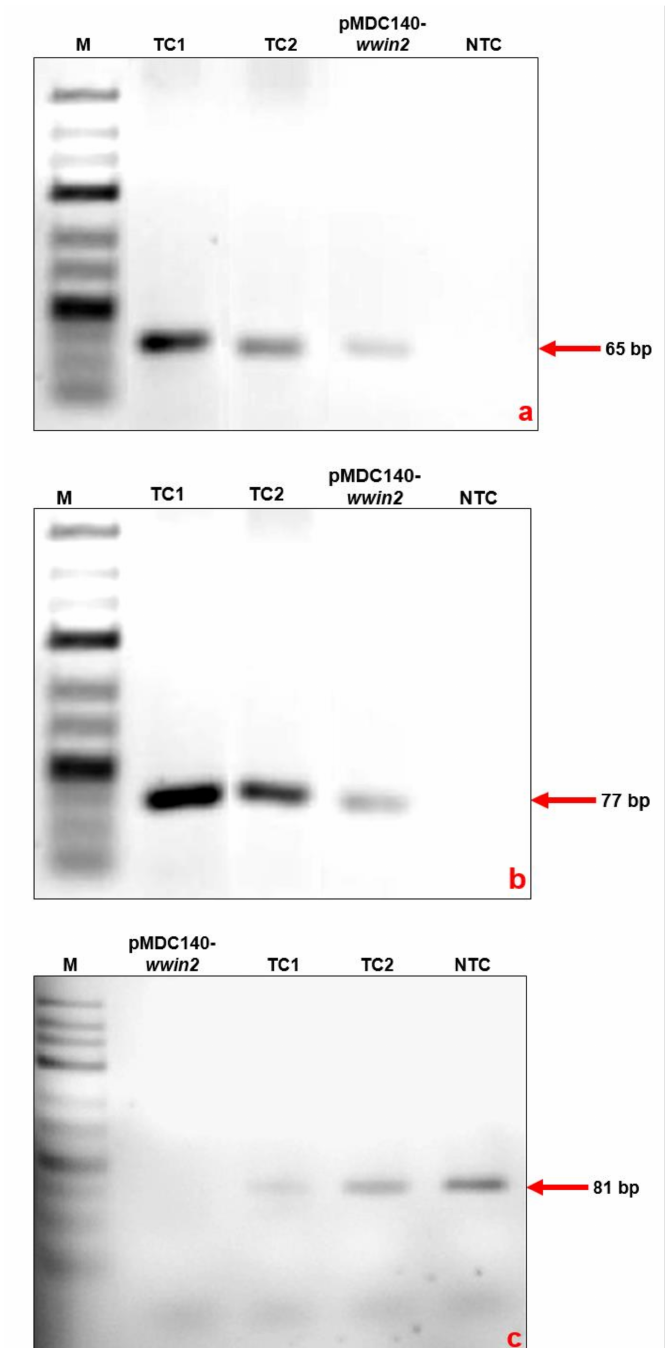
Figure 4. RT-PCR for the presence of transgenes in the cDNA of two representative transformed rice calli, a representative of non-transformed callus, and the constructed pMDC140- wwin2 plasmid. ( a ) wwin2 gene, ( b ) hptII gene, and ( c ) sps gene. M: Thermo Scientific TM GeneRuler TM Low-Range DNA Ladder; TC1: transformed callus 1; TC2: transformed callus 2; NTC: non-transformed cal- lus